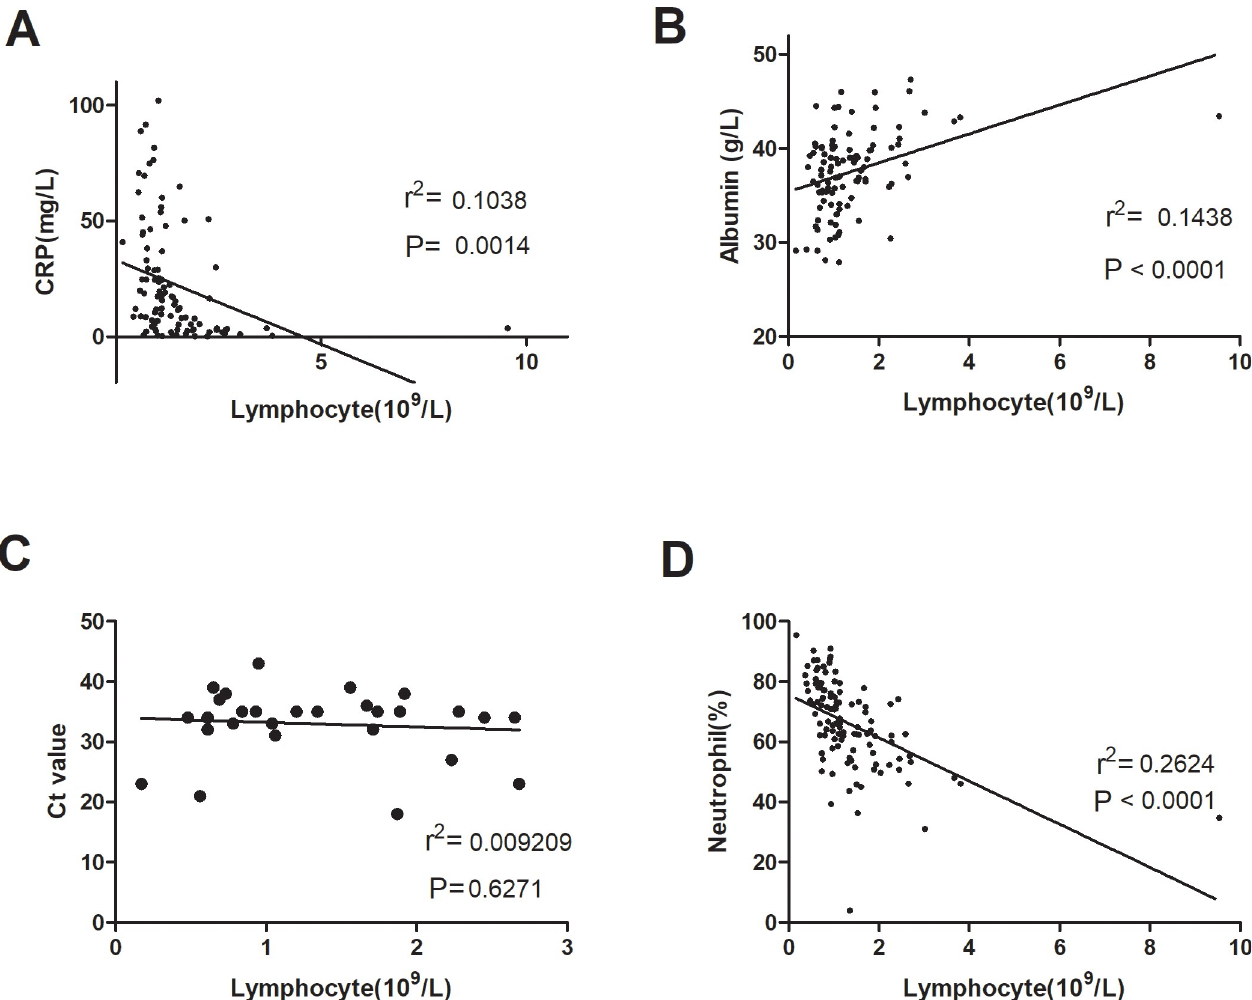
Fig 2. Correlation of lymphocyte count and laboratory tests. Lymphopenia was highly correlated with CRP levels (A), serum albumin levels (B) and neutrophil counts (D). No significant correlation was found between lymphocyte count and Ct value (C). Spearman rank correlation analysis (r) and P values are provided in each graph. CRP, C-reactive protein; Ct value, cycle threshold